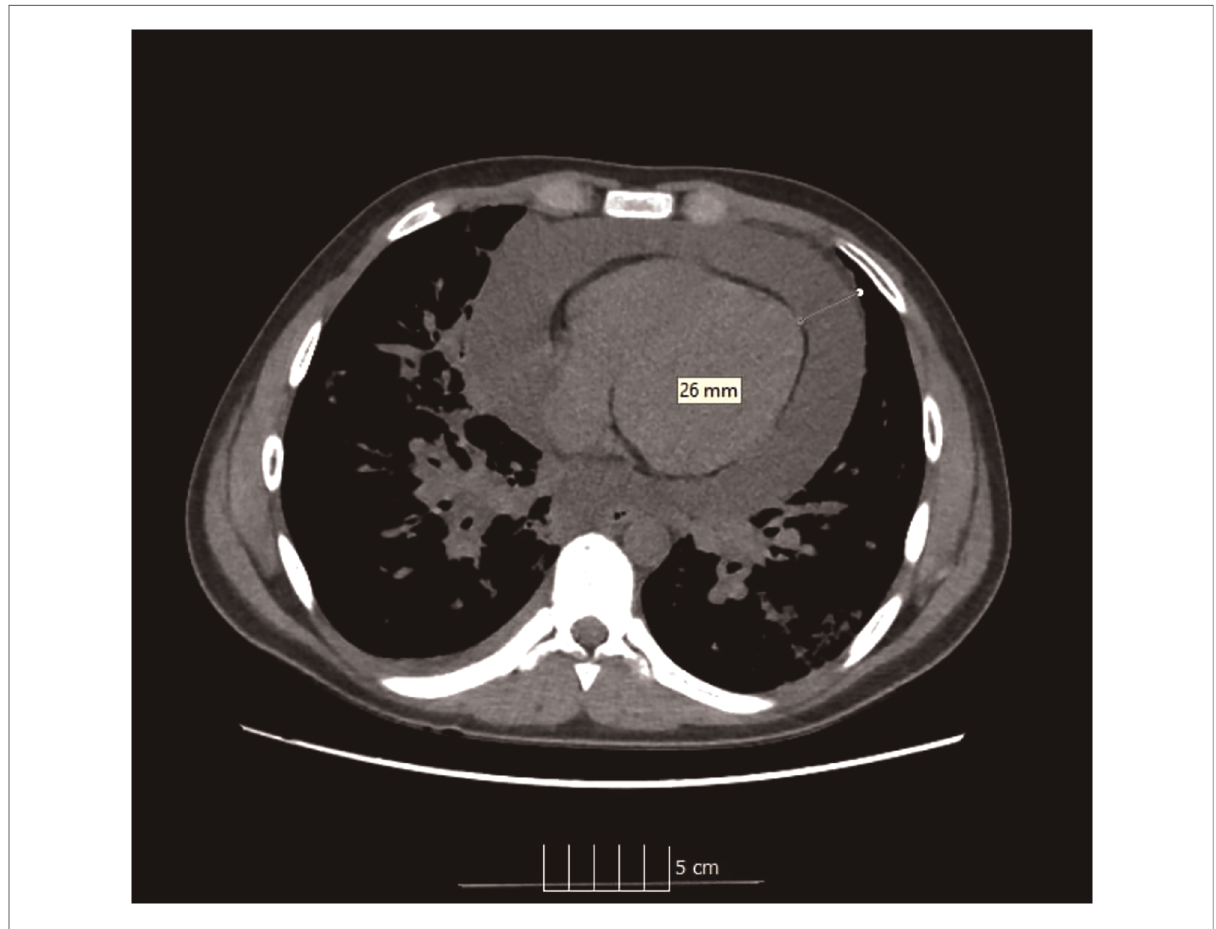
FIGURE 1 Ct image of pericardial